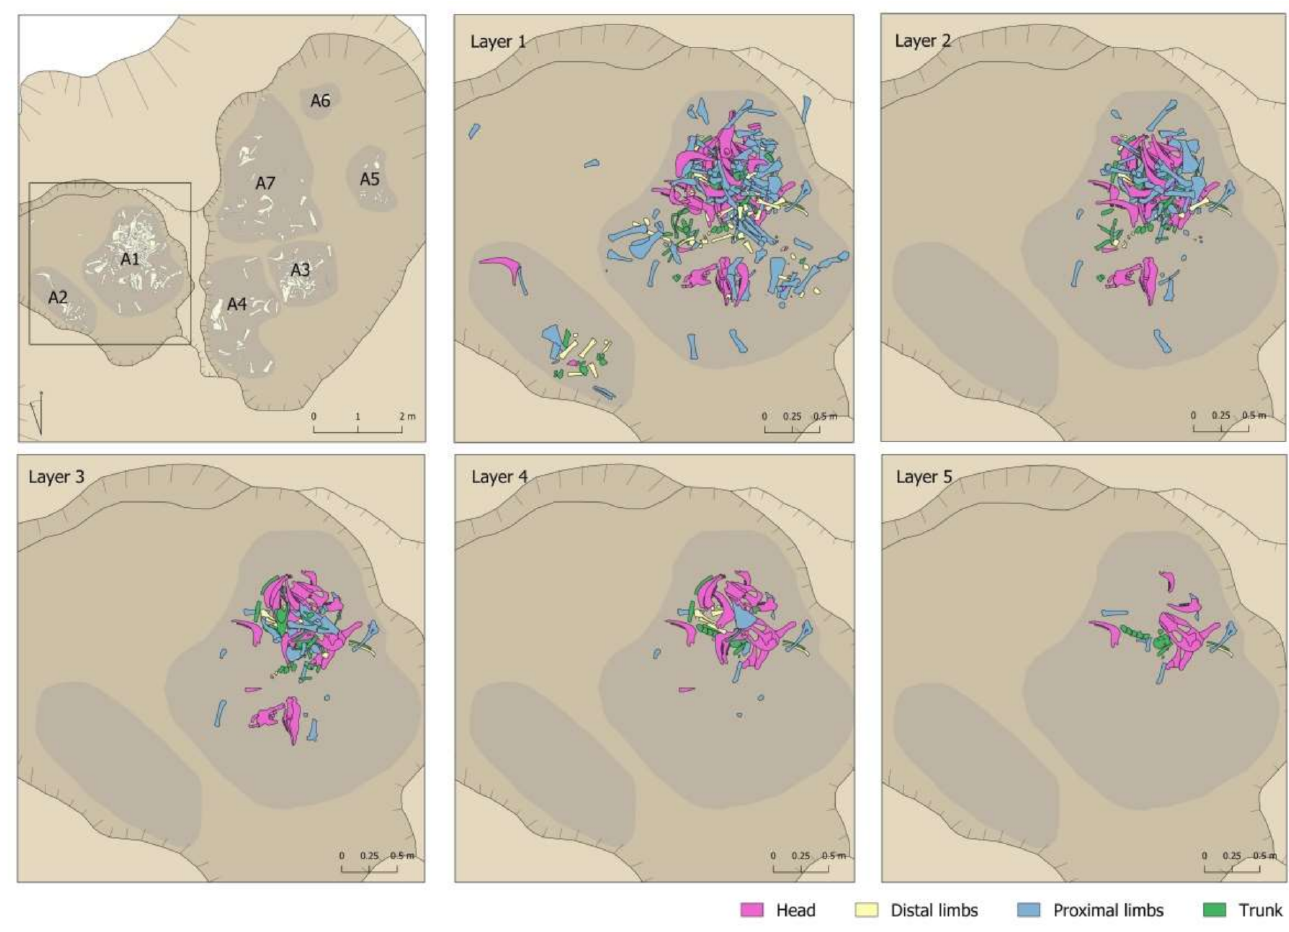
Figure 8. Body-part representation documented in the different layers of Areas 1 and 2 of the Vilauba